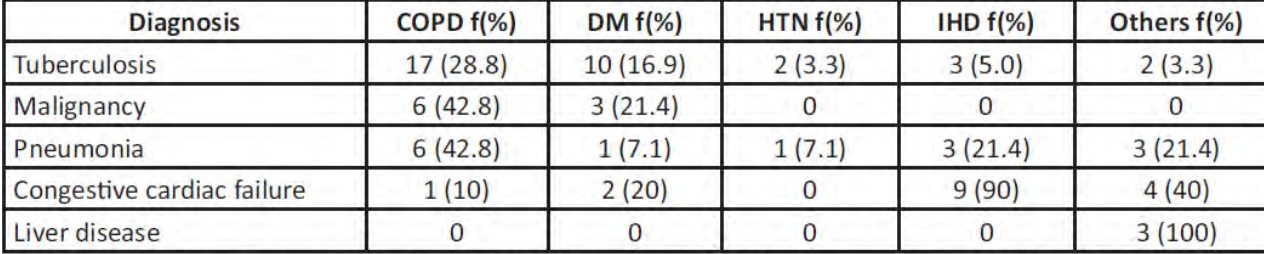
Table 3: Comorbidities in patients with pleural